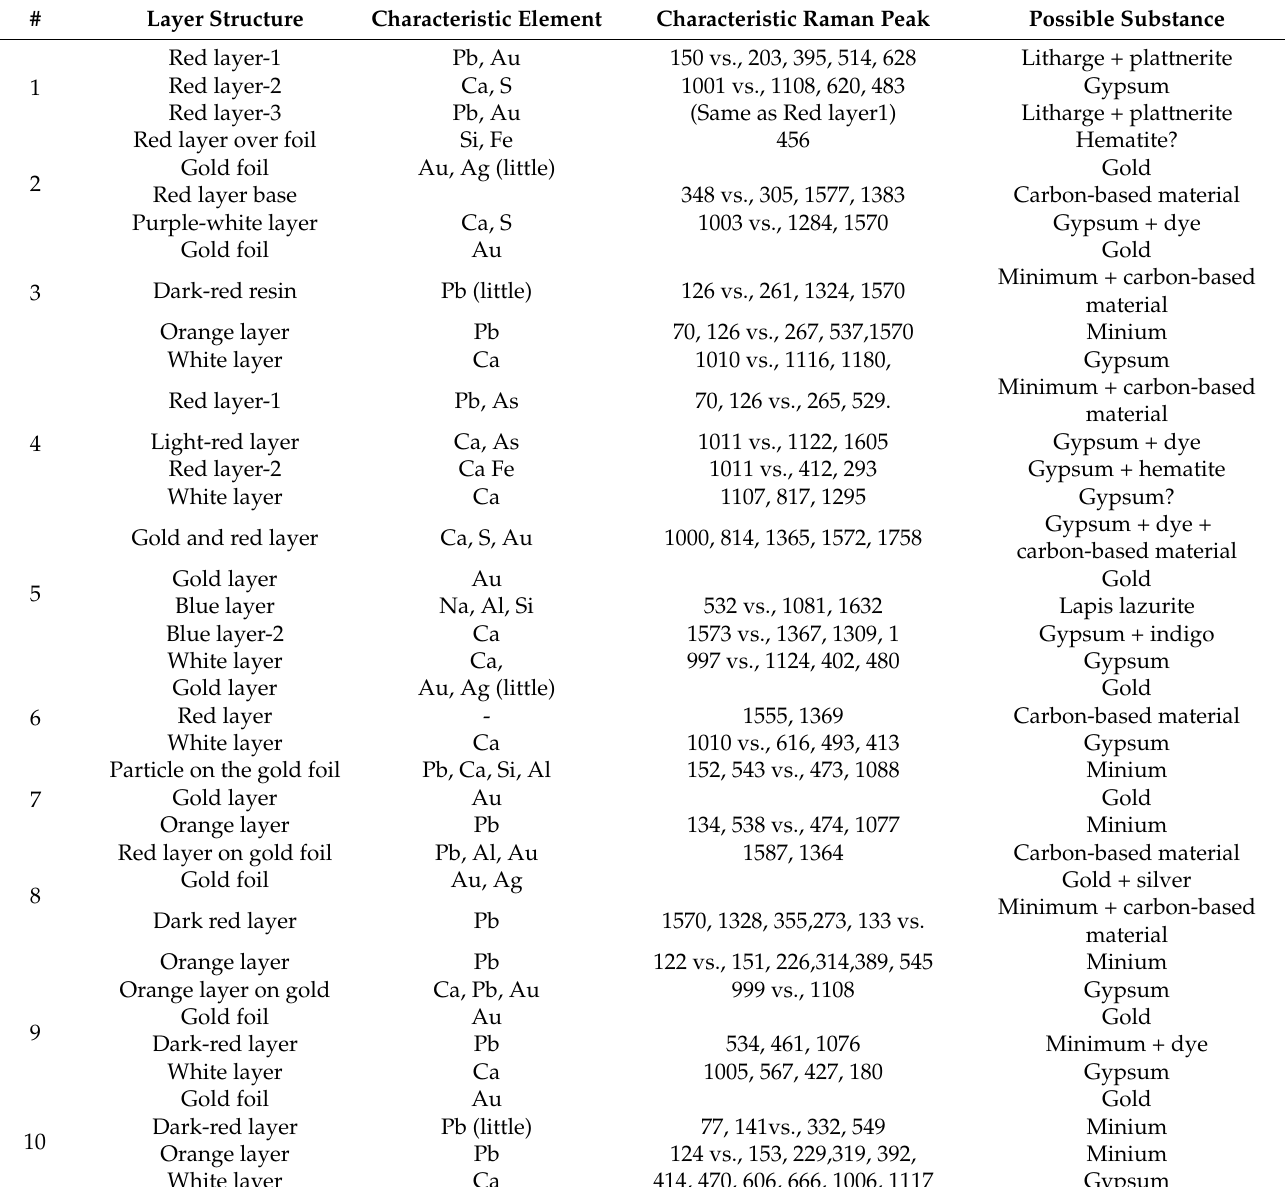
Table 2. Summary of elemental and Raman analysis